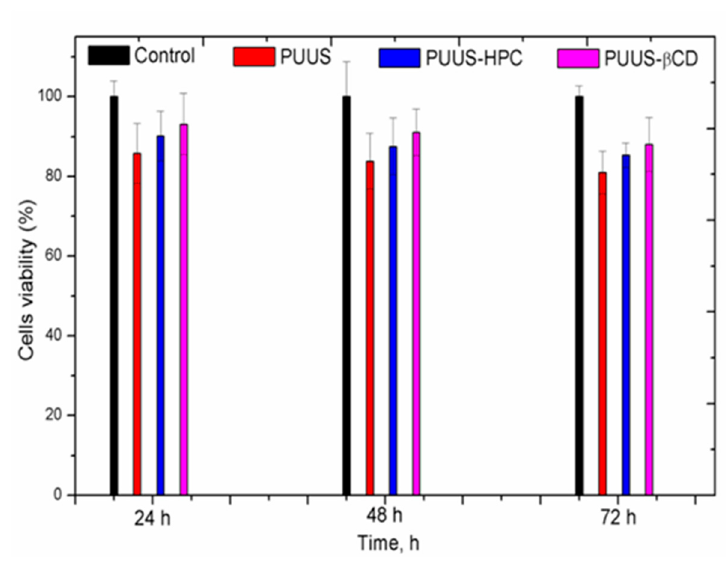
Figure 10. MTT assay of nanofibrous mat (PUUS) and nanofibrous composite mats (PUUS-HPC and PUUS- β CD).